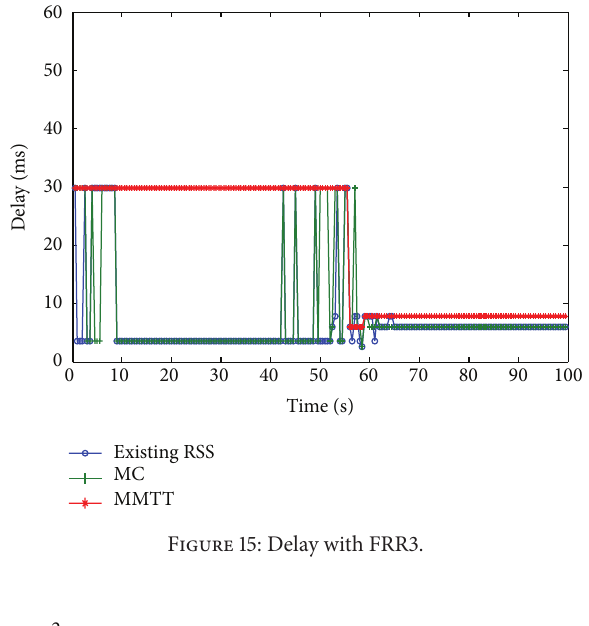
Figure 15: Delay with FRR3.